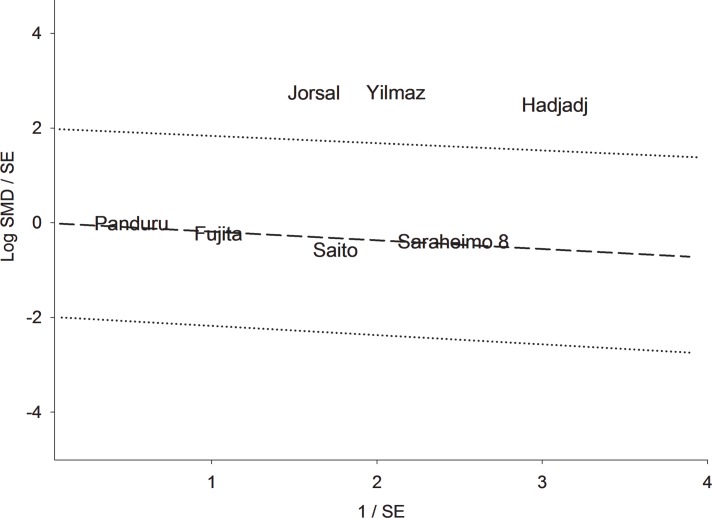
Galbraith plot analysis of outliers from the control versus macroalbuminuria comparison.LEGEND: SMD: standardized mean difference; SE: standard error.